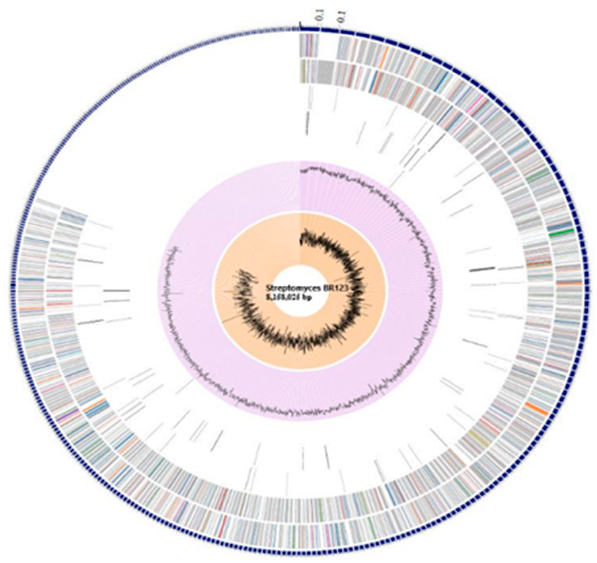
Figure 1. Circular map of the Streptomyces isolate BR123 genome, retrieved from PATRIC version 3.6.9. Description of each circle is given from outside in: CDS on the forward strand, CDS on the reverse strand, RNA genes, CDS with homology to known antimicrobial resistance genes, CDS with homology to known virulence factors, GC content, and GC skew. Table 1. General genomic features of Streptomyces sp. isolate BR123 and other species used in this